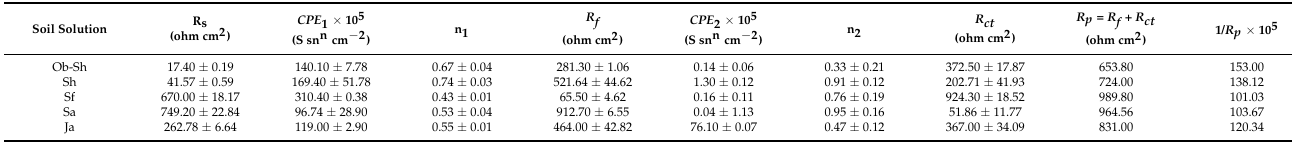
Table 4. EIS parameters for the corrosion of CSX36 specimens in the studied Jeddah soil solutions at 30 ± 1 ◦ C.